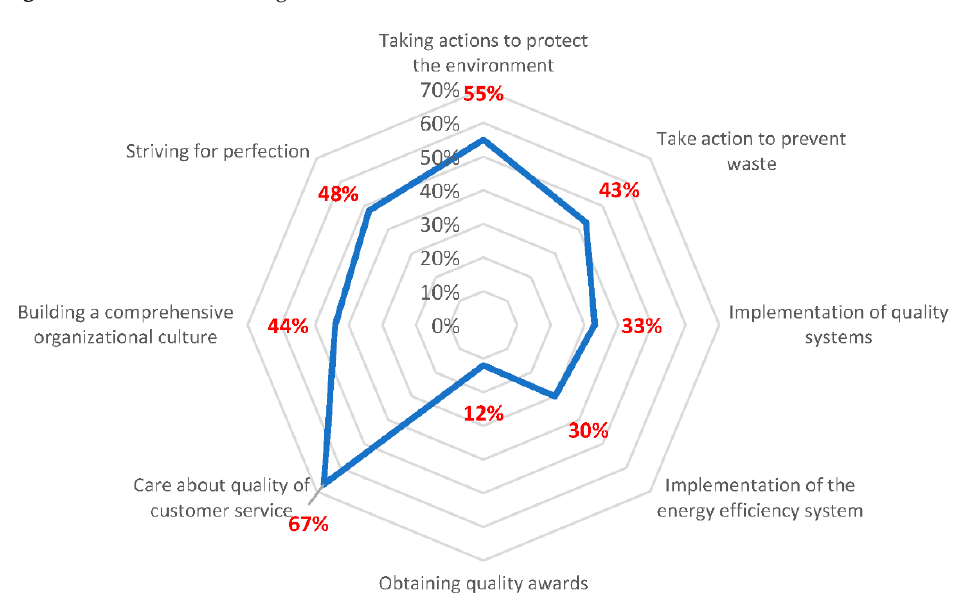
Figure 5. Elements determining the quality of an energy company .